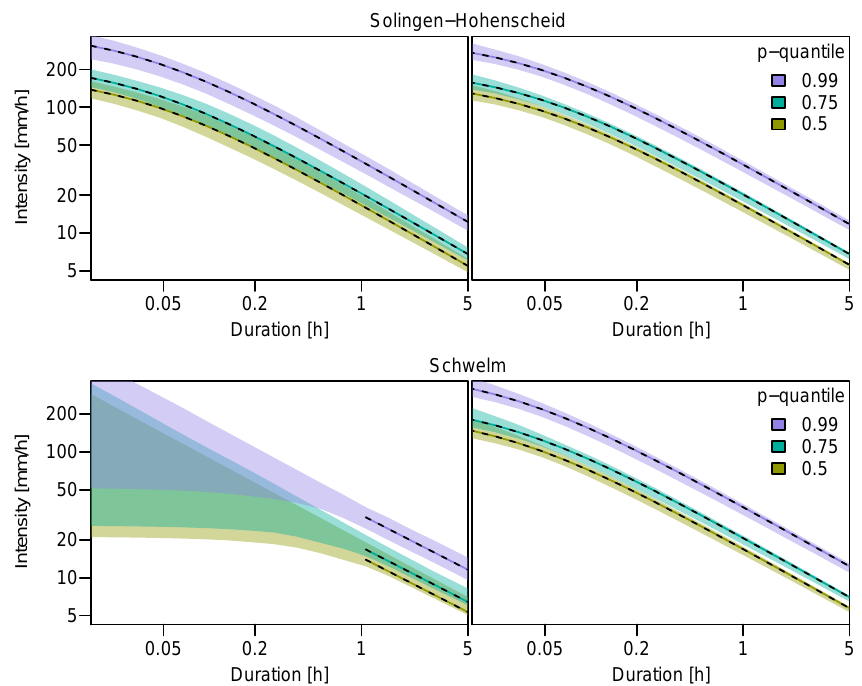
Figure 9. Bootstrapped 95% confidence intervals for IDF-estimates at the example stations Solingen-Hohenscheid and Schwelm (marked in Figure 1), using the station-wise d-GEV (left column) and the spatial d-GEV approach (right